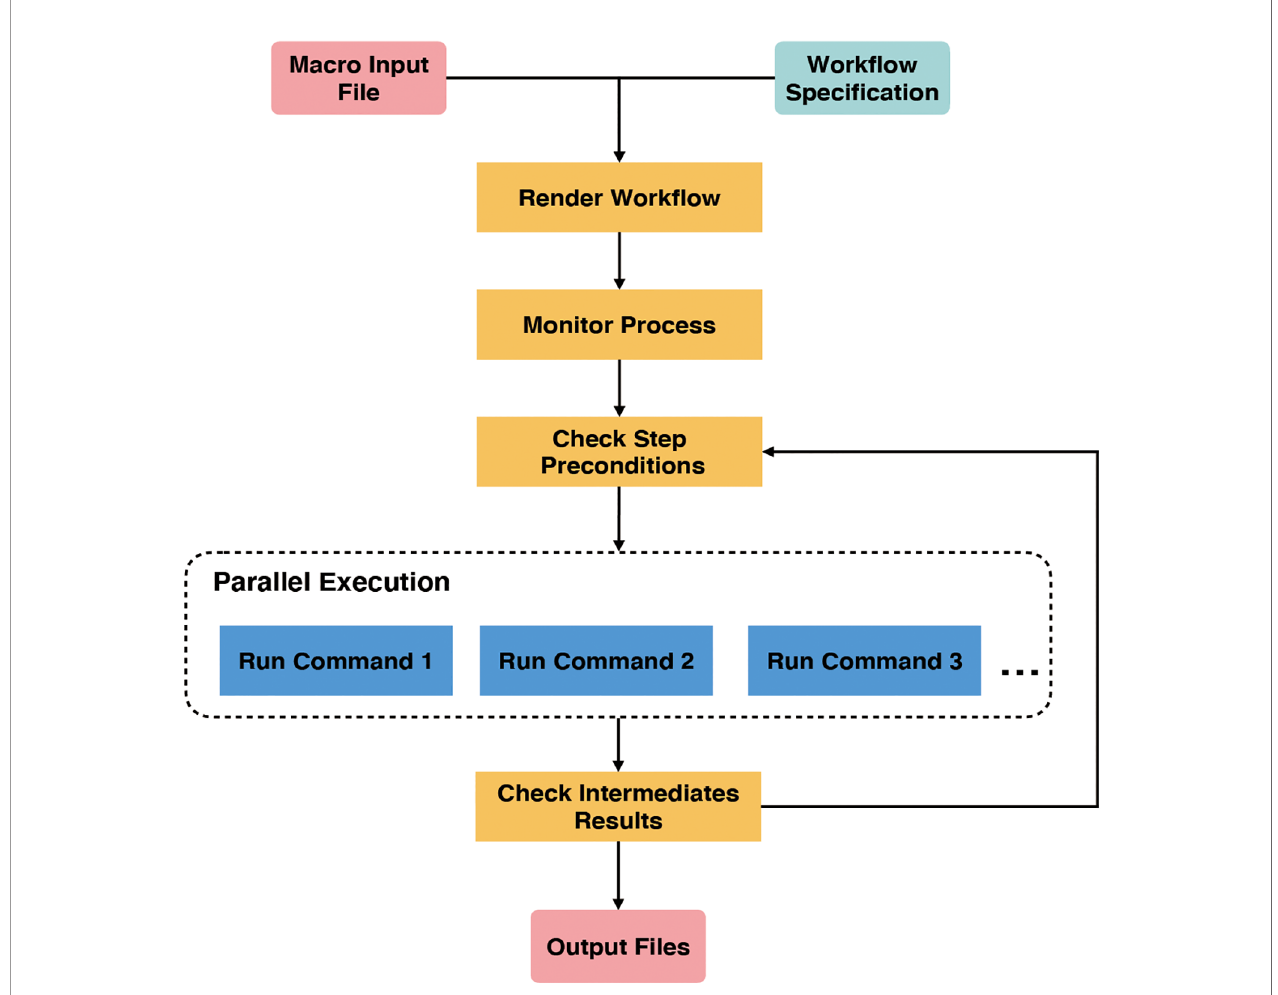
FIGURE 4 | Internal mechanism of